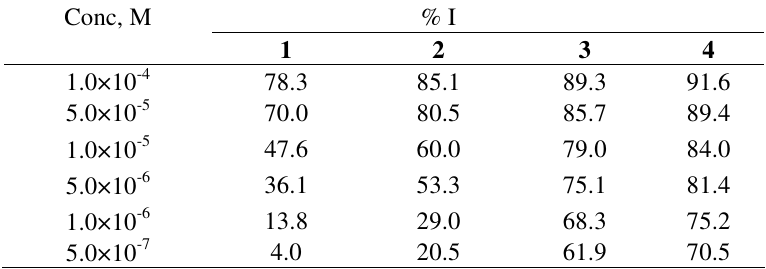
Figure 2. Effect of organic compounds concentration on inhibition efficiency (%I) for corrosion of copper in 2.0 M HNO 4.0 h immersion at 25 °C